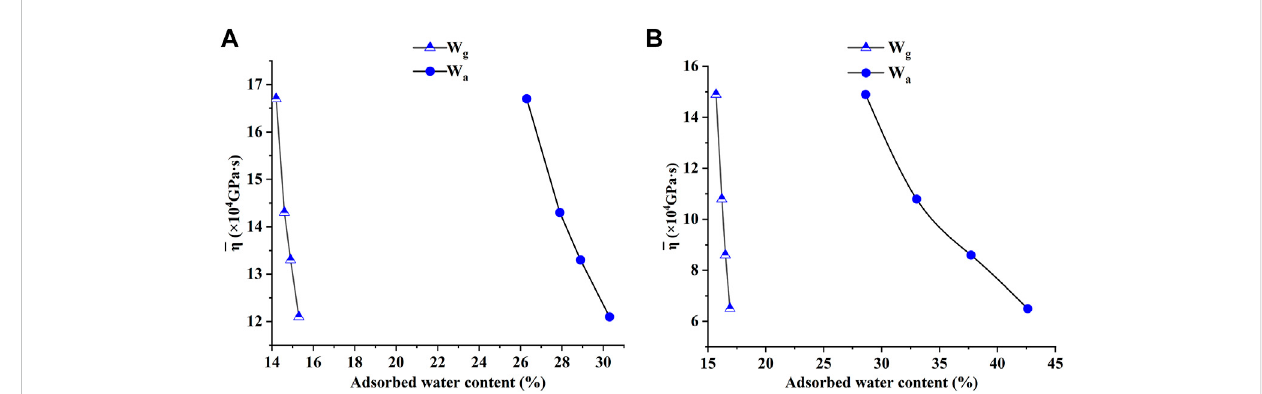
FIGURE 7 Curve of the average viscosity coef fi cient of samples with the adsorbed water content. (A) Kaolin; (B) bentonite.